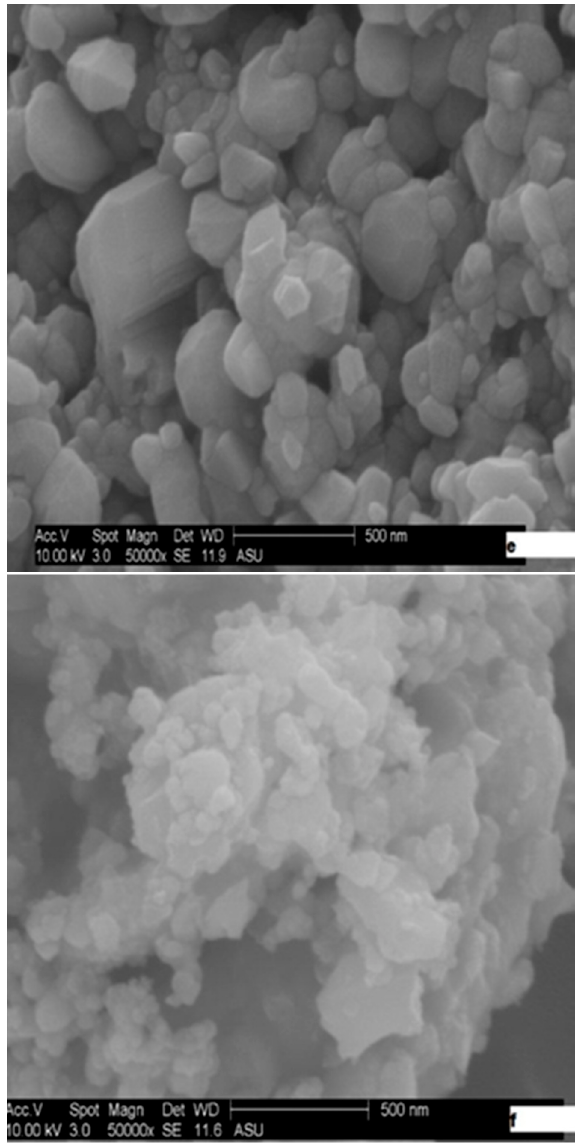
Figure 4. SEM images of the surface morphology of copper ferrites dopped with molybdenum ( a ) CuFe 2 O 4 ; ( b ) CuFe 1.92 Mo 0.04 O 4 ; ( c ) CuFe 1.88 Mo 0.06 O 4 ; ( d ) CuFe 1.84 Mo 0.08 O 4 1 μ m; ( e ) CuFe 1.88 Mo 0.06 O 4 ; ( f ) CuFe 1.84 Mo 0.08 O 4 , 500 nm.